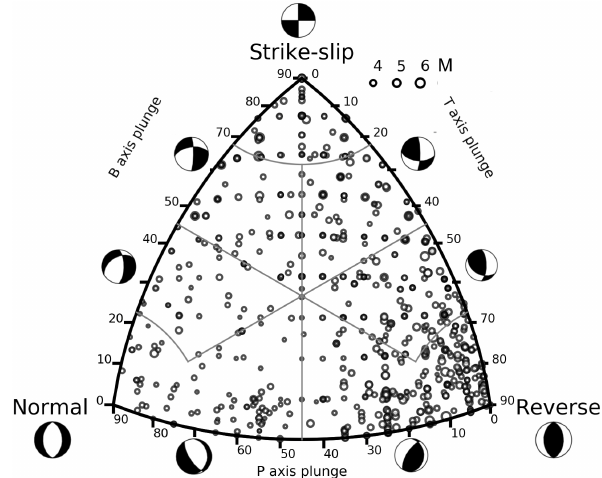
Figure 5. Focal mechanism classification of our catalogue plotted on a ternary diagram (Kaverina et al.,